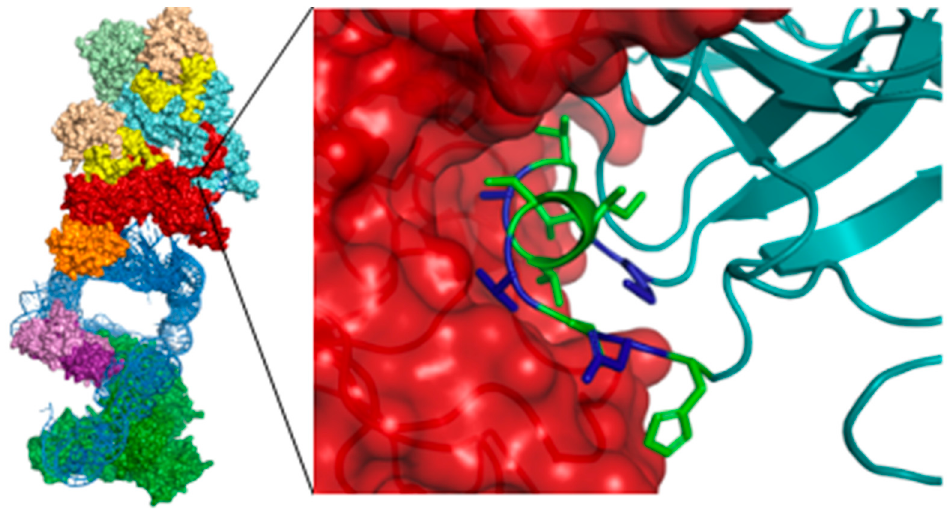
Figure 14. Left: Full telomerase structure, right: dyskerin-dyskerin PPI with derived peptide high- lighted in green and the mutated residues commonly found in Dyskeratosis Congenita in this section highlighted in dark blue.